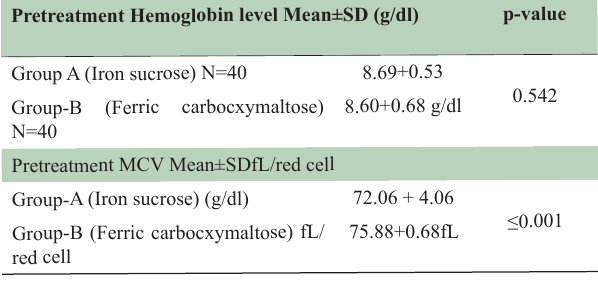
Table-II: Pre-treatment Hemoglobin level and mean capsular volume comparing both groups.